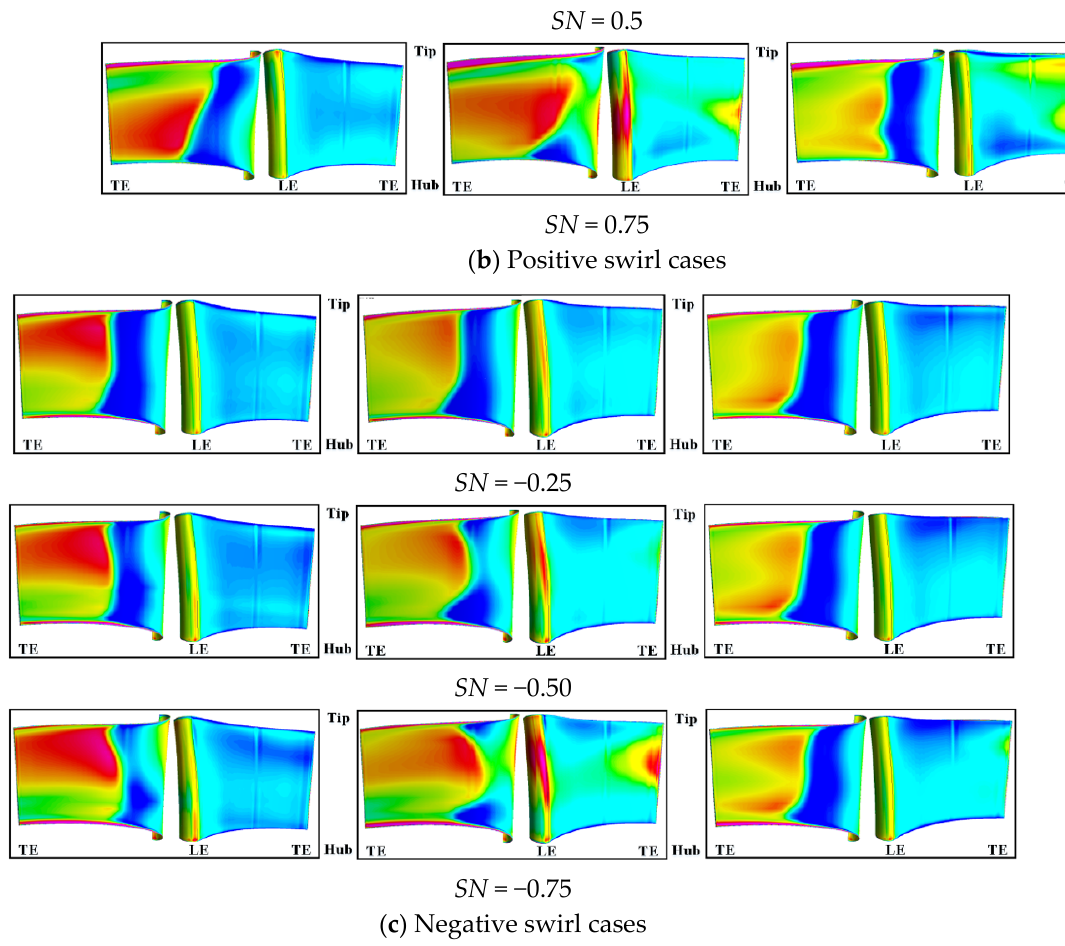
Figure 22. Nusselt number distributions on NGV surfaces (from left to right are NGV1, NGV2 and NGV3, respectively).